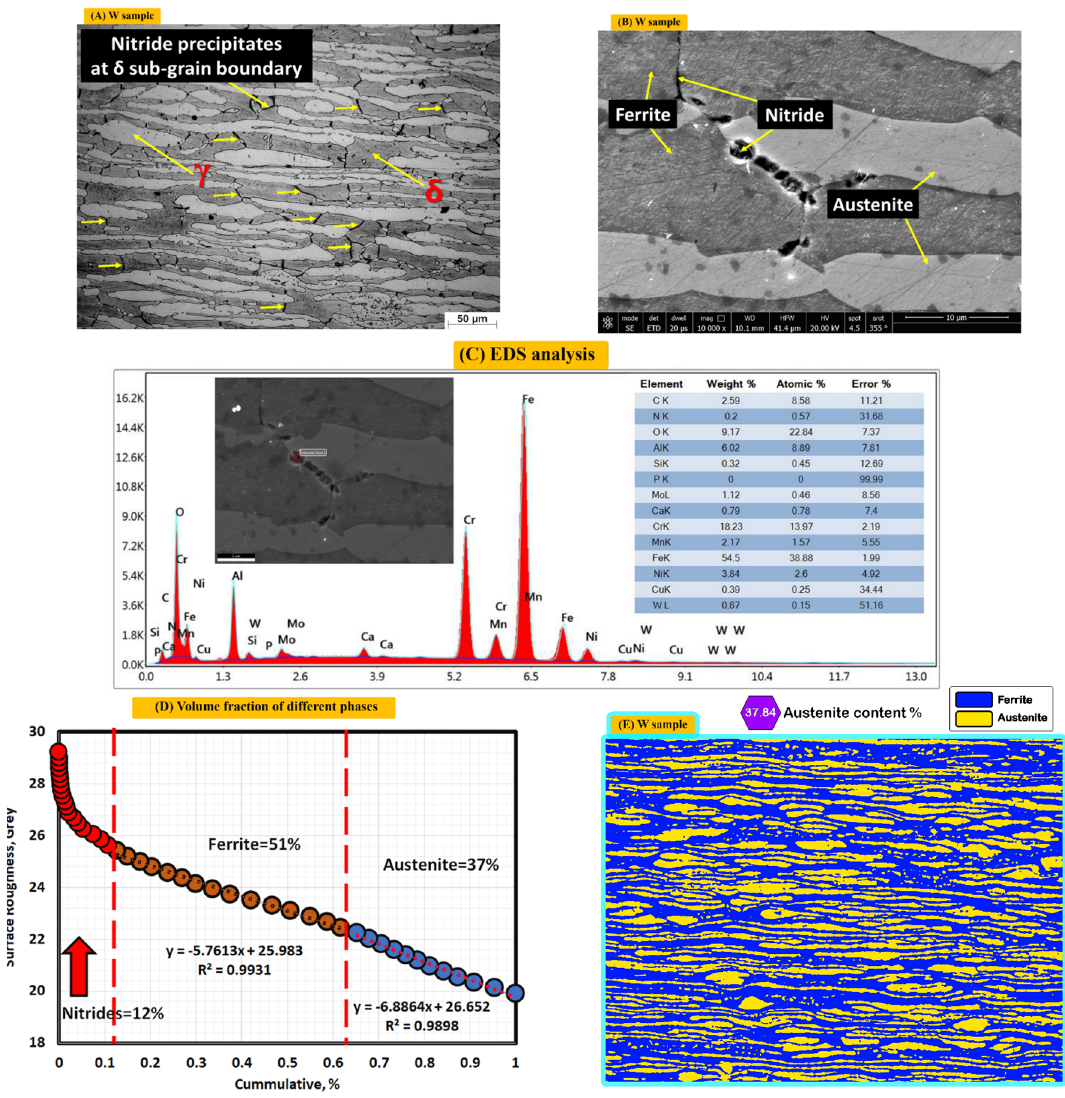
Figure 4. Optical, SEM micrograph, EDS analysis and different volume fraction of different phases for base metal, ( A ) optical microstructure, ( B ) SEM photo, ( C ) EDS analysis, ( D ) volume fraction by MATLAB, and ( E ) volume fraction by Image